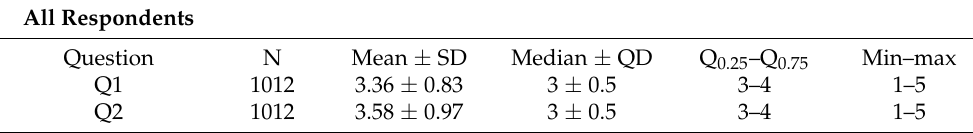
Table 5. Statistics of respondents’ answers for questions Q1 and Q2.